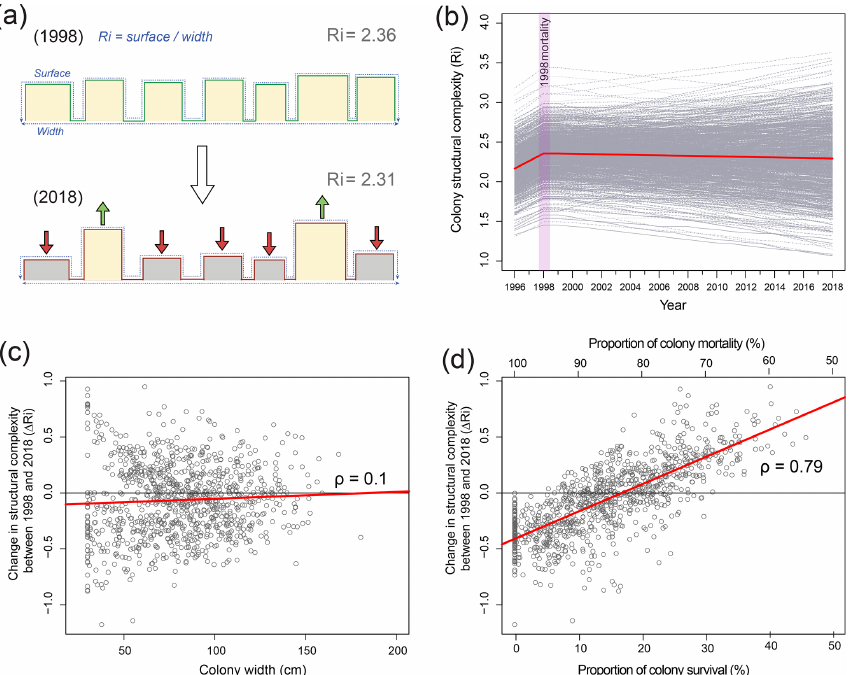
Figure 3. (a) Cross-sectional structural model of Orbicella annularis , indicating the method of estimating structural complexity ( R refers to the surface perimeter/width) and changes in R in 1998 (100% live prior to mortality) and 2018 following mortality. (b) Results of 1000 model simulations of changes in structural complexity between 1997 and 2018 (grey lines) and average values across simulations (red line). (c) Change in the structural complexity between 1998 and 2018 ( (cid:49)R ) of 1000 simulated colonies against colony size, and (d) the proportion of colony survival/mortality.